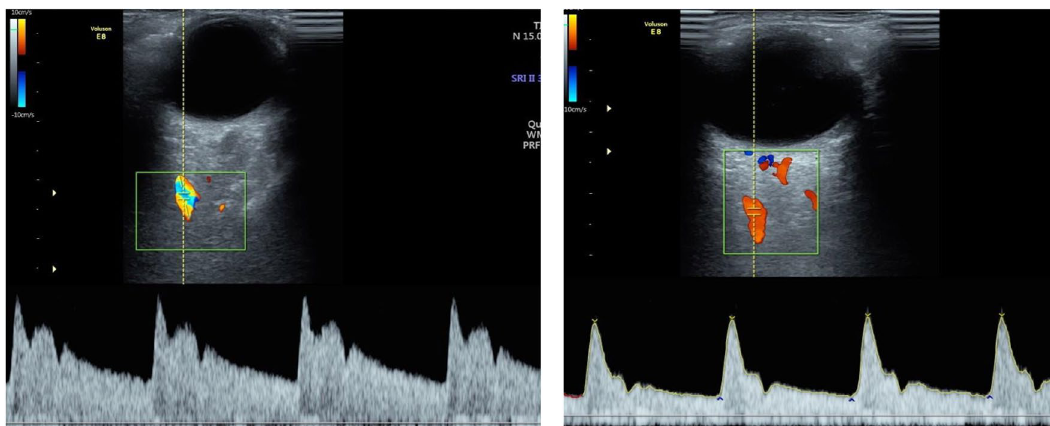
Figure 2. Ophthalmic artery Doppler demonstrating different wave morphology with elevation of the second peak systolic velocity P2 and peak ratio (on the left) compared to Doppler waveform with low P2 and peak ratio in non-smokers group (on the